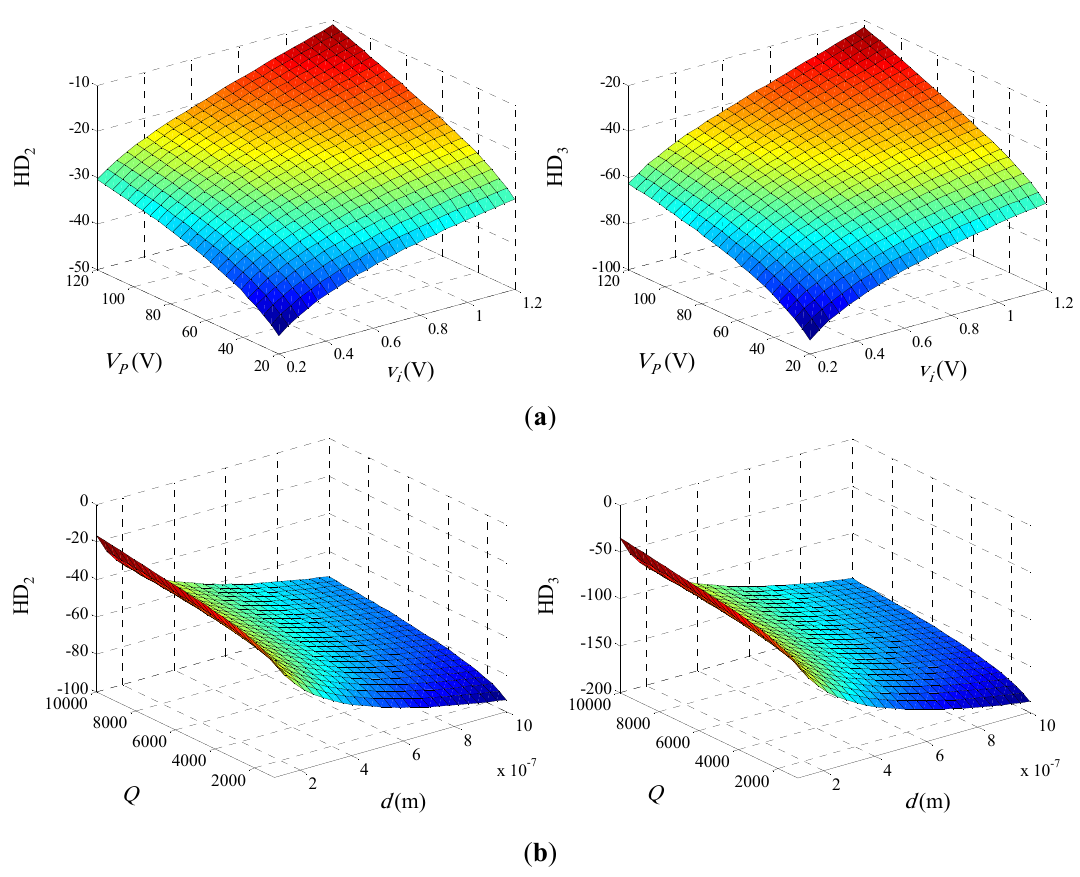
Figure 11. ( a ) The effect of the operating conditions on HD for EWG ring resonator with Q = 8,000 and d = 90 nm; ( b ) The effect of the design parameters on HD for EWG ring resonator with V = 100 V and v = 1 P i